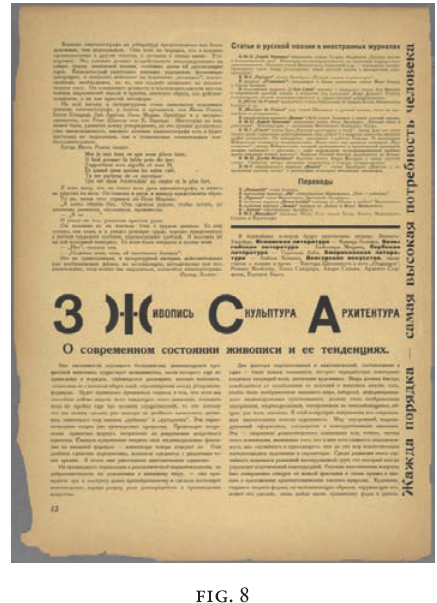
“Vešč’-Gegenstand-Objet”, i-ii, p. 4 “Vešč’-Gegenstand-Objet”, i-ii, p. 12